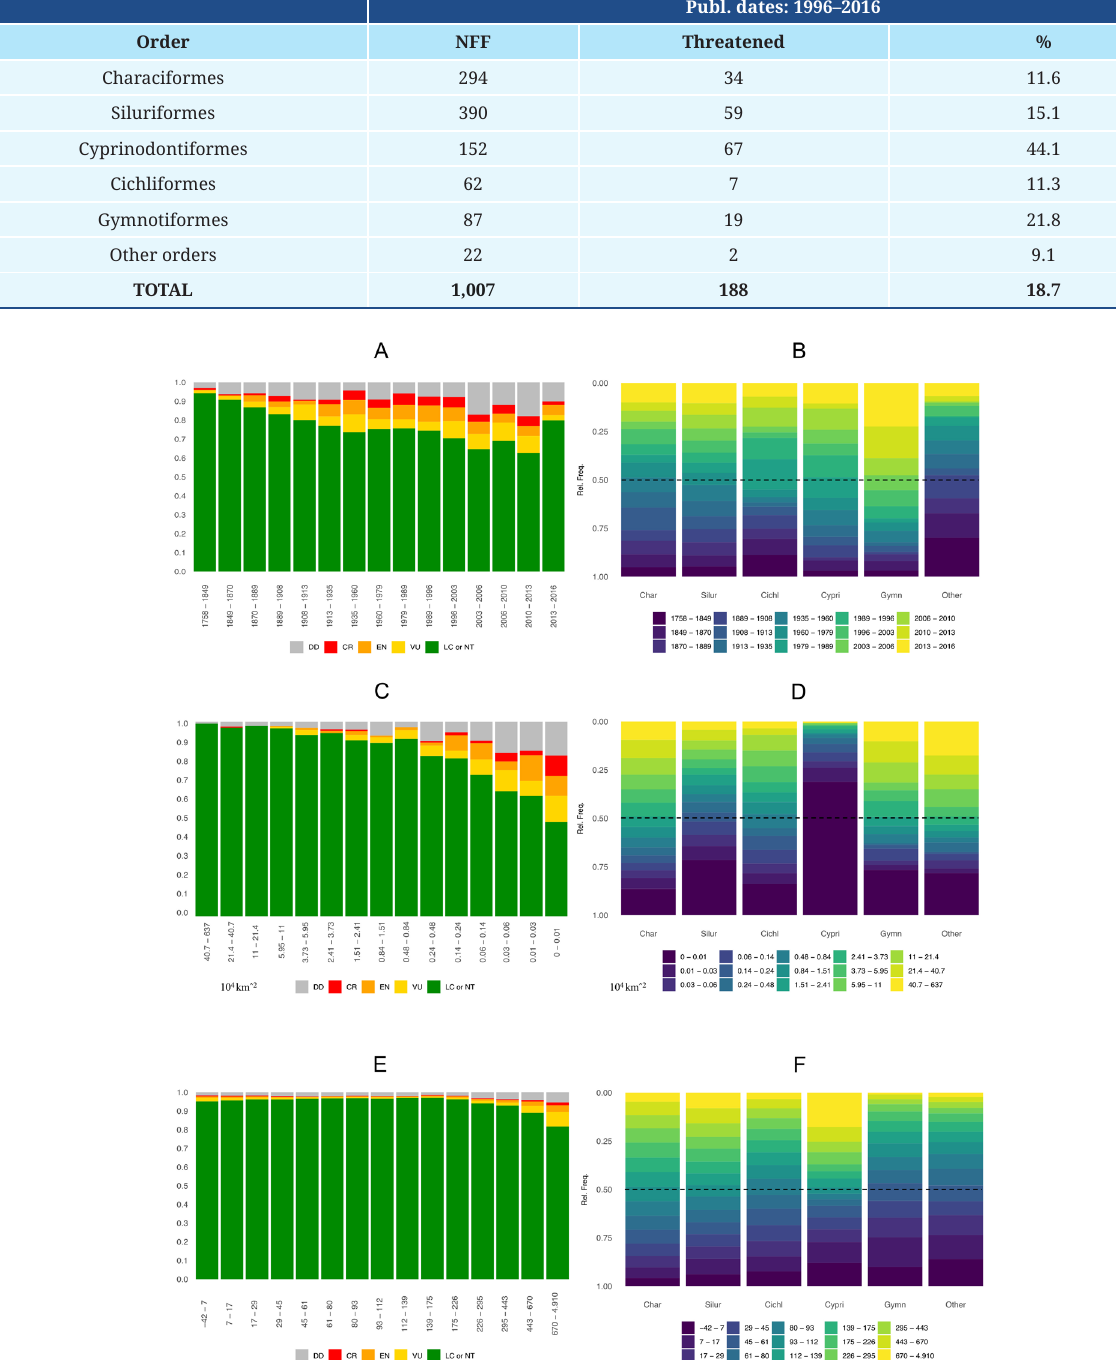
FIGURE 3 | Association among three variables and extinction risks in 3,001 Neotropical freshwater fishes (NFF). A. IUCN-Red List (RL) threat categories by species description dates. B. Species description dates by taxonomic orders. C. IUCN-RL categories by geographic ranges. D. Geographic ranges by taxonomic orders. E. IUCN-RL categories by elevation ranges. F. Elevational ranges by taxonomic orders. Threatened status are usually higher for recently described NFF species, those inhabiting narrow geographic ranges, and those confined to upland river drainages. CR: Critically Endangered; EN: Endangered; VU: Vulnerable; DD: Data Deficient.